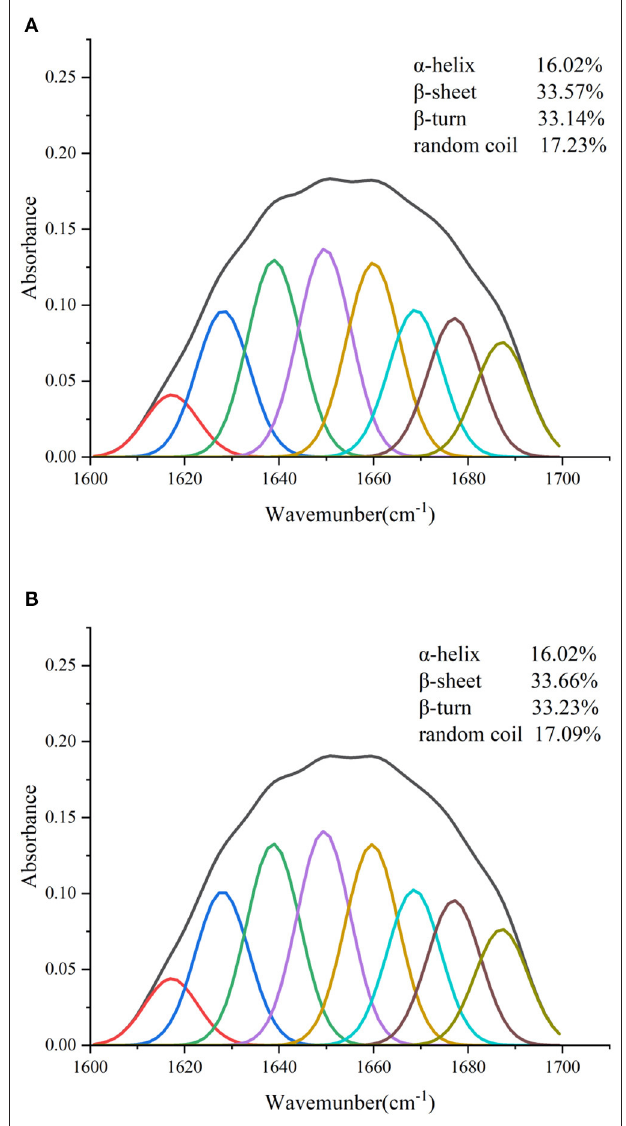
FIGURE 6 | Fourier transform infrared spectrogram of GSPI and GSPI–lutein in the region of 1,600–1,700 cm − 1 . (A) GSPI and (B)